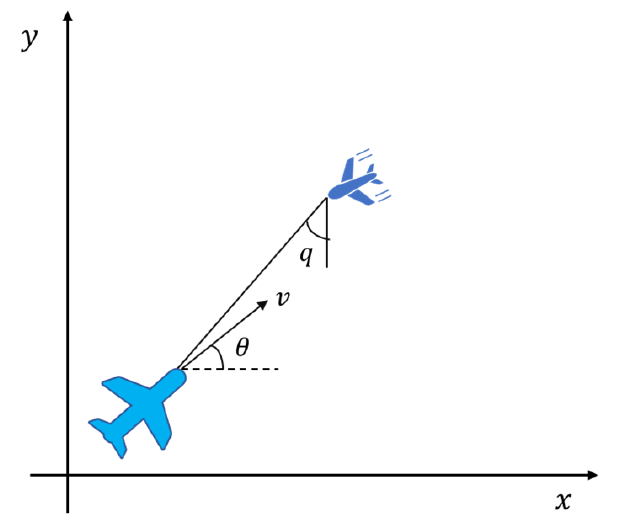
Figure 3. Schematic diagram of interceptor’s movement.